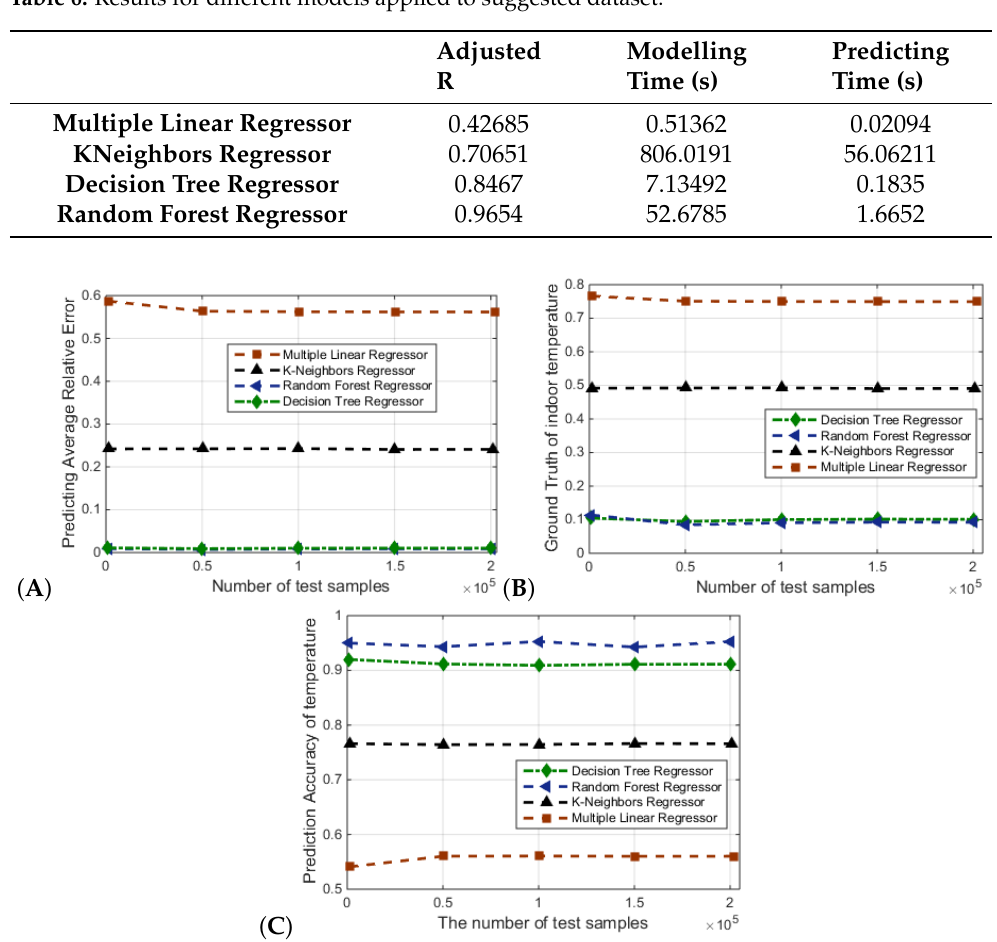
Figure 4. Comparison between machine learning algorithms in predicting the indoor temperature. ( A ) Prediction error. ( B ) Ground Truth. ( C ) Prediction